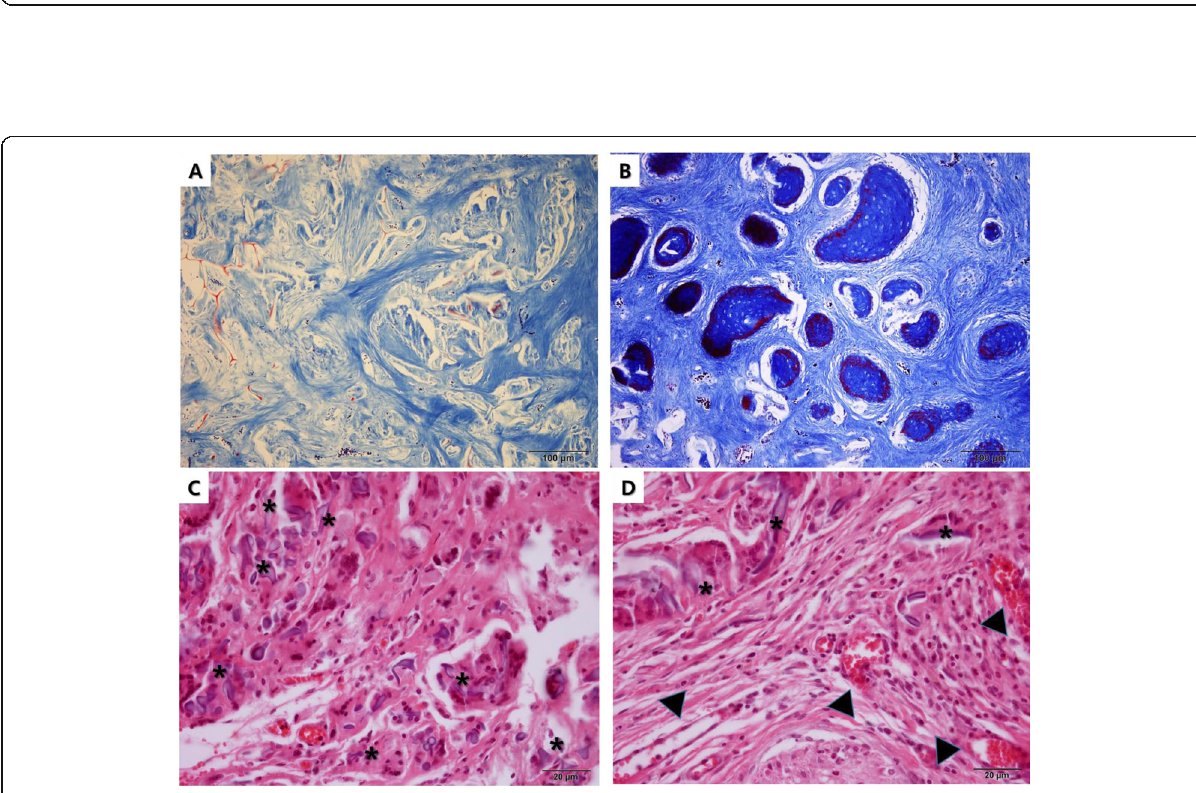
Fig. 5 Accelerated tissue regeneration by incorporating 4-hexylresorcinol (4HR). a Silk and hydroxyapatite grafts were implanted into calvarial defects of rabbits. There was no bone regeneration at 8 weeks postoperation (Masson trichrome stain, original magnification ×100). b A silk fibroin, hydroxyapatite, and 4HR graft were implanted into the calvarial defect of a rabbit. There were numerous osteoid islands at 8 weeks postoperation (Masson trichrome stain, original magnification ×100). c A silk fibroin graft was implanted into the dermal pocket of a rat. There were many foreign body giant cells (asterisks) with silk fiber remnants at 12 weeks postoperation (HE stain, original magnification ×400). d A silk fibroin and 4HR graft were implanted into the dermal pocket of a rat. There were few foreign body giant cells (asterisks) at 12 weeks postoperation. Interestingly, capillary regenerations were prominent (arrow heads) (HE stain, original magnification